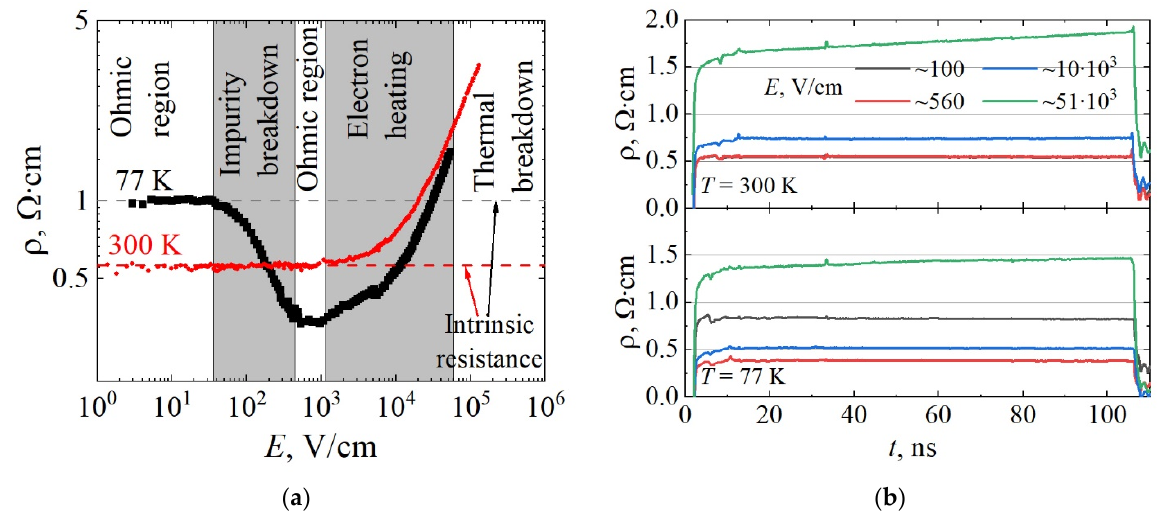
Figure 8. ( a ) Resistivity versus electric field characteristics obtained from the corresponding experimental data shown in Figure 7. ( b ) Resistivity kinetics during the electric pulse in various electric field regions: E ≈ 100 V/cm, black lines (impurity breakdown), E ≈ 560 V/cm, red lines (Ohmic), E ≈ 10 kV/cm, blue lines (electron heating), and E ≈ 51 kV/cm, green lines (electron and lattice heating with the rapid change in the latter during the entire pulse).